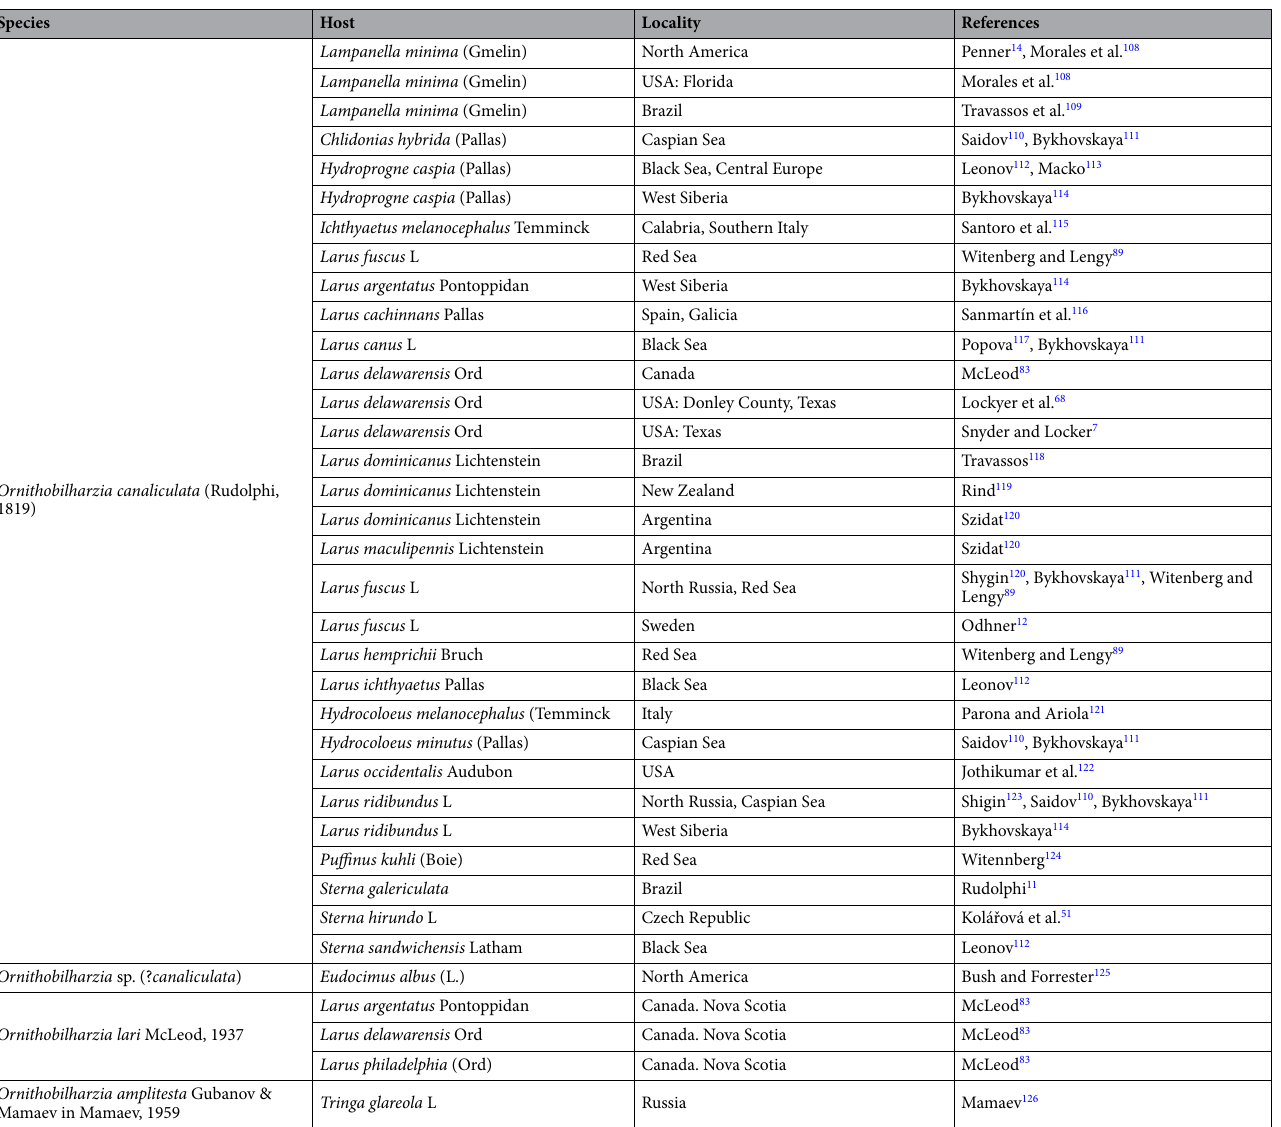
Table 1. Records of Ornithobilharzia spp . and Austrobilharzia